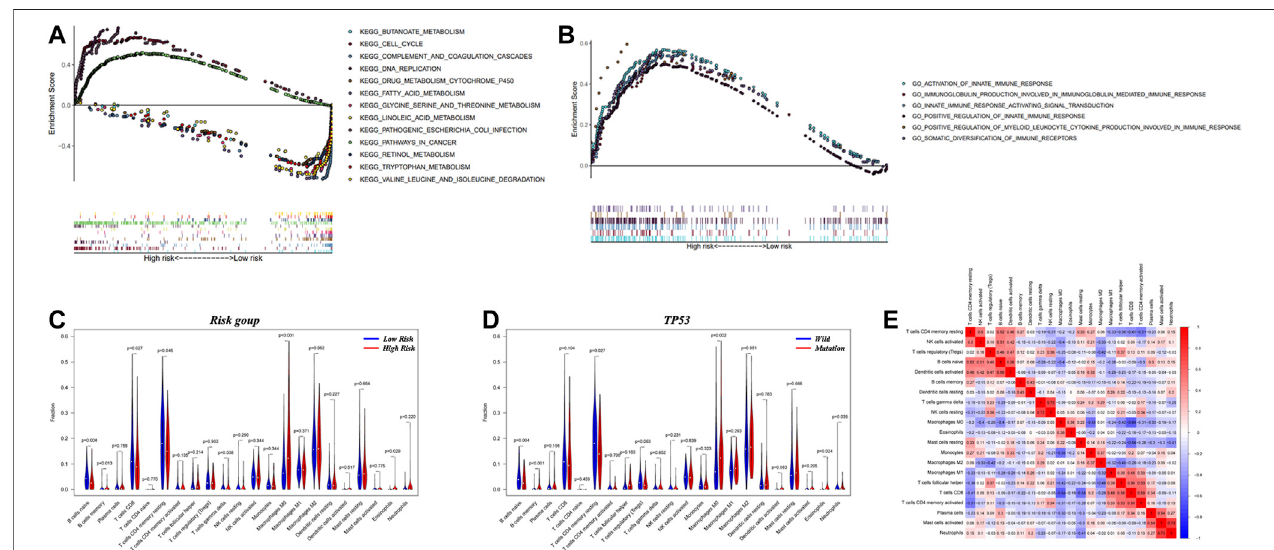
FIGURE5| TheresultsofgenesetenrichmentanalysisbasedonKyotoEncyclopediaofGenesandGenomes(KEGG)andGeneOntology(GO)databasesandthe assessment of in fi ltrated immune cells. (A) Four signi fi cantly enriched KEGG pathways in high-risk group. Nine signi fi cantly enriched KEGG pathways in low-risk group. (B) Six signi fi cantly enriched GO pathways in high-risk group. (C) Relative proportion of immune cell in fi ltration in high- and low-risk patients. (D) Relative proportion of immune cell in fi ltration in TP53 mutation and normal status patients. (E) Correlation matrix of all 21 immune cell proportions. The red color represents positive correlation and the blue color represents negative